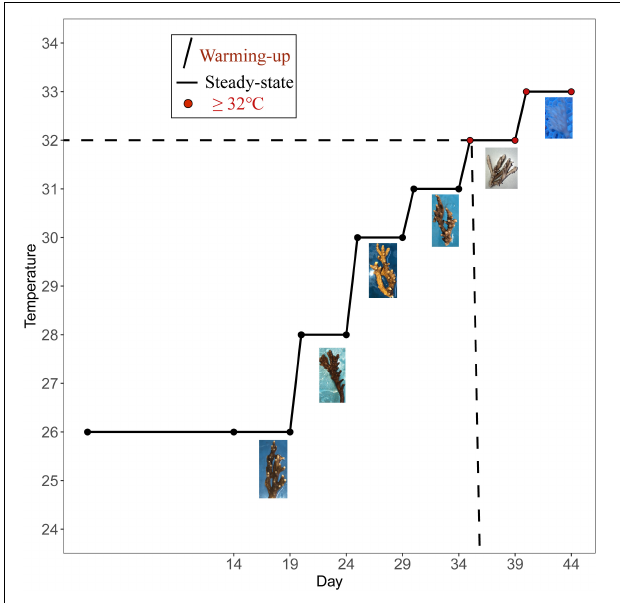
FIGURE 1 | Different temperature treatments and sampling time